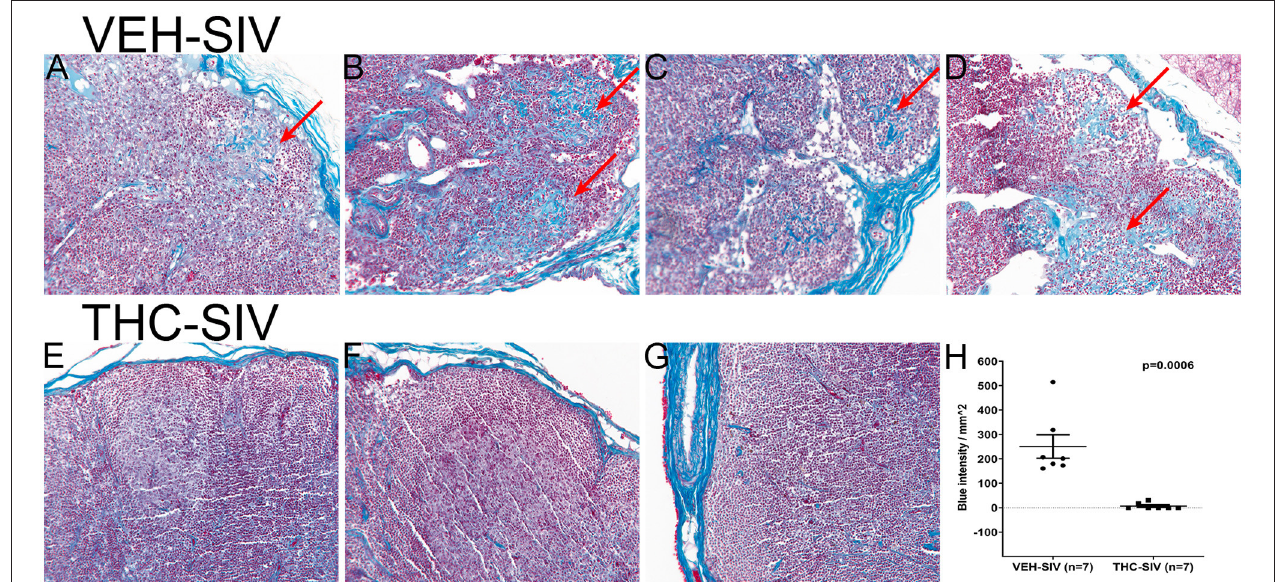
FIGURE 5 | VEH/SIV rhesus macaques have significantly high amounts of collagen deposition in lymph node paracortex and B-cell follicles (A–D) (red arrows) compared to THC/SIV rhesus macaques (E–G) . Note blue staining collagen (red arrow) (Gomori one-step trichrome stain) in (A–D) . Image quantification confirmed high collagen deposition in lymph nodes of VEH/SIV rhesus macaques (H) .